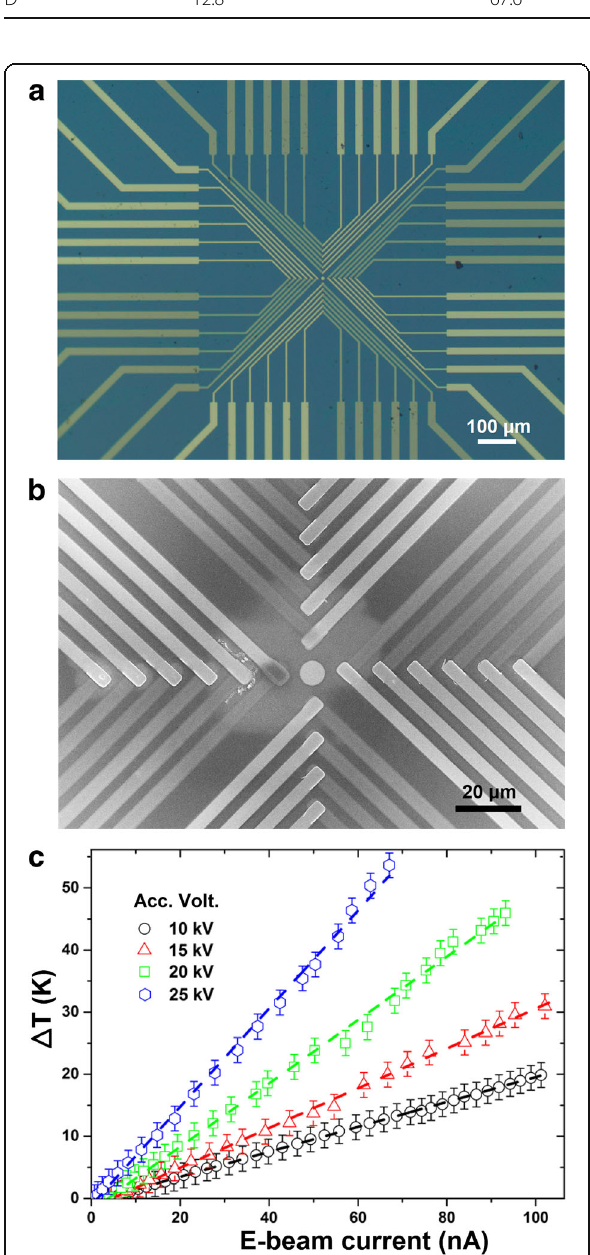
Fig. 4 Images TFTC samples in Si and the testing results. a Optical image of a TFTC array on Si with junction size of 5.0 × 5.0 μ m 2 . b SEM image of the device center, showing 24 sensor